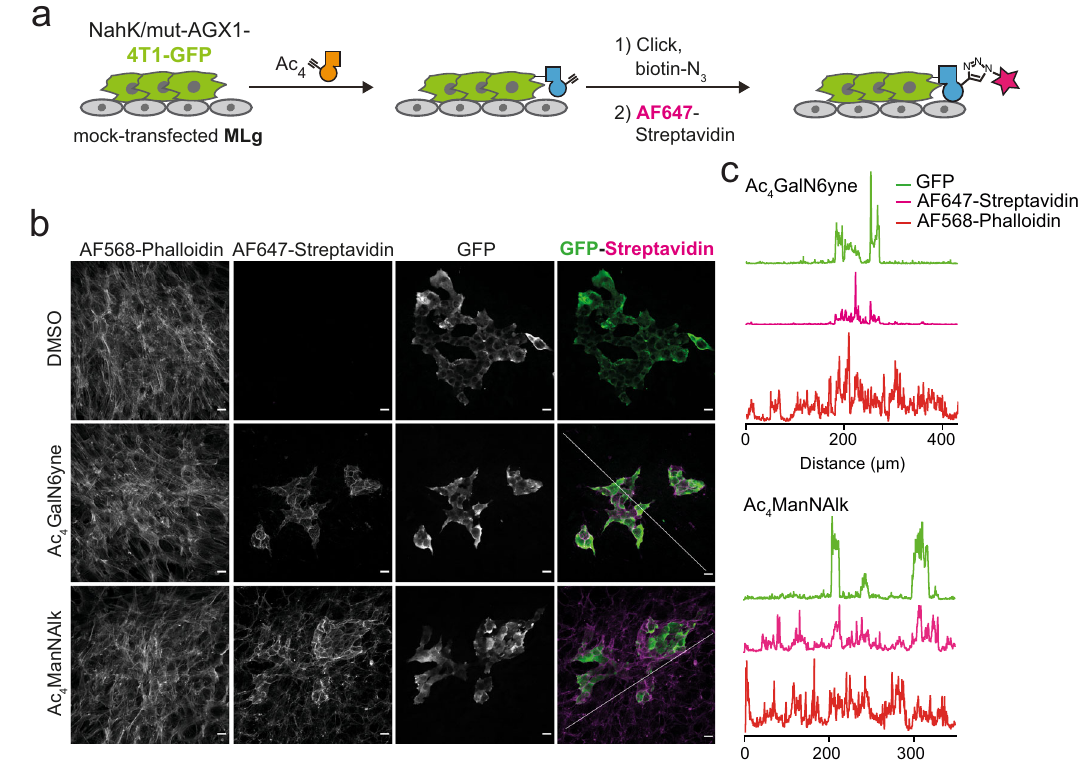
fl uorescent signal between GFP and AF647 in Ac 4 GalN6yne- (top) or Ac 4 ManNAlk- fed (bottom) co-cultures. The intensity pro fi les of GFP, AF647-Streptavidin and AF568-Phalloidin signals were measured along a diagonal line drawn across the fl uorescent image. Data are representative of one out of two independent experi- ments. Source data are provided as a Source Data fi